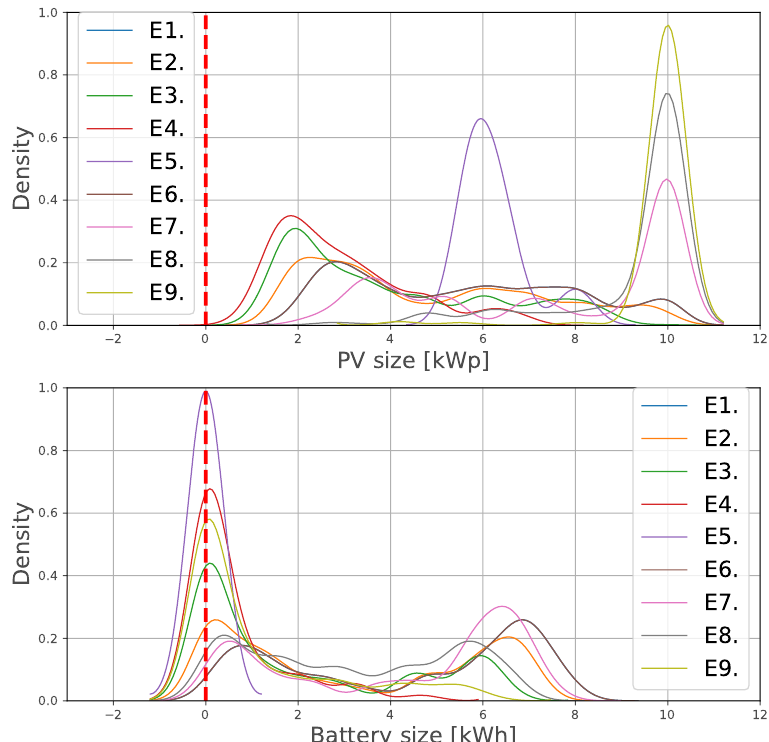
Figure 5. Gaussian kernel density estimation of the installed capacity of PV (upper plot), and of batteries (lower plot). These figures represent the probability density function for the kernel density estimation of PV and battery capacities, for every environment (E1–E9). This probability is computed based on the calculated DER installation size of the set I .